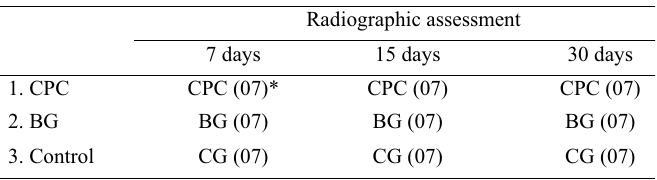
TABLE 1 - Distribution of groups in the respective observation time points according to type of material